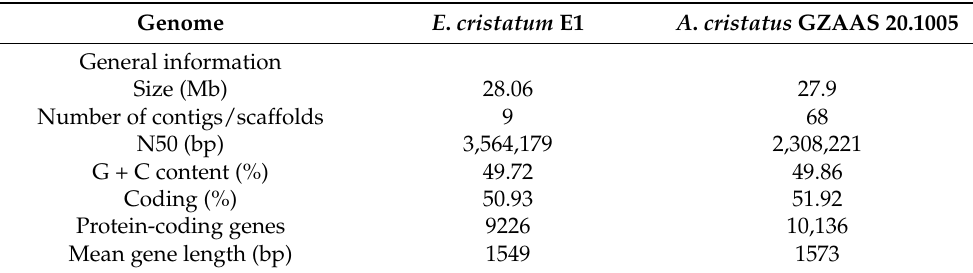
Table 1. General feature of E . cristatum E1 genome and A . cristatus GZAAS 20.1005 genome.